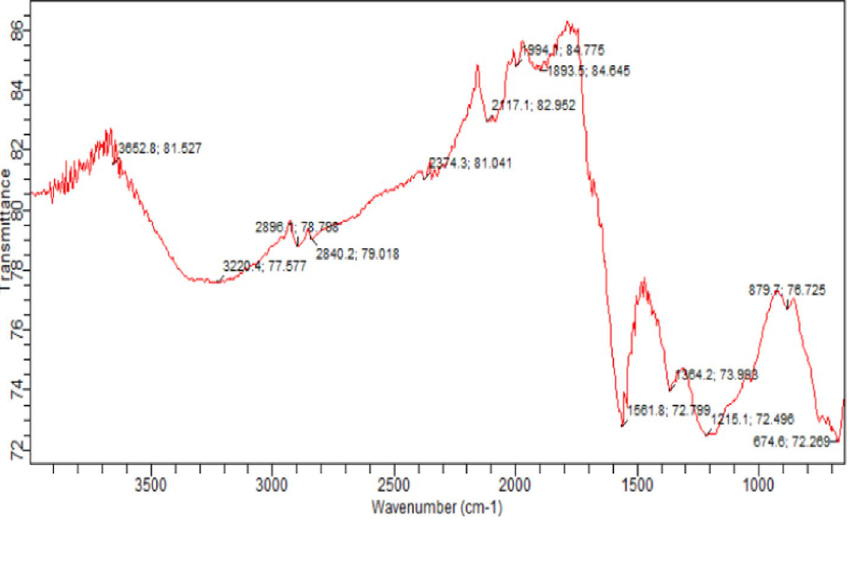
Fig. 4 FT-IR spectrum for